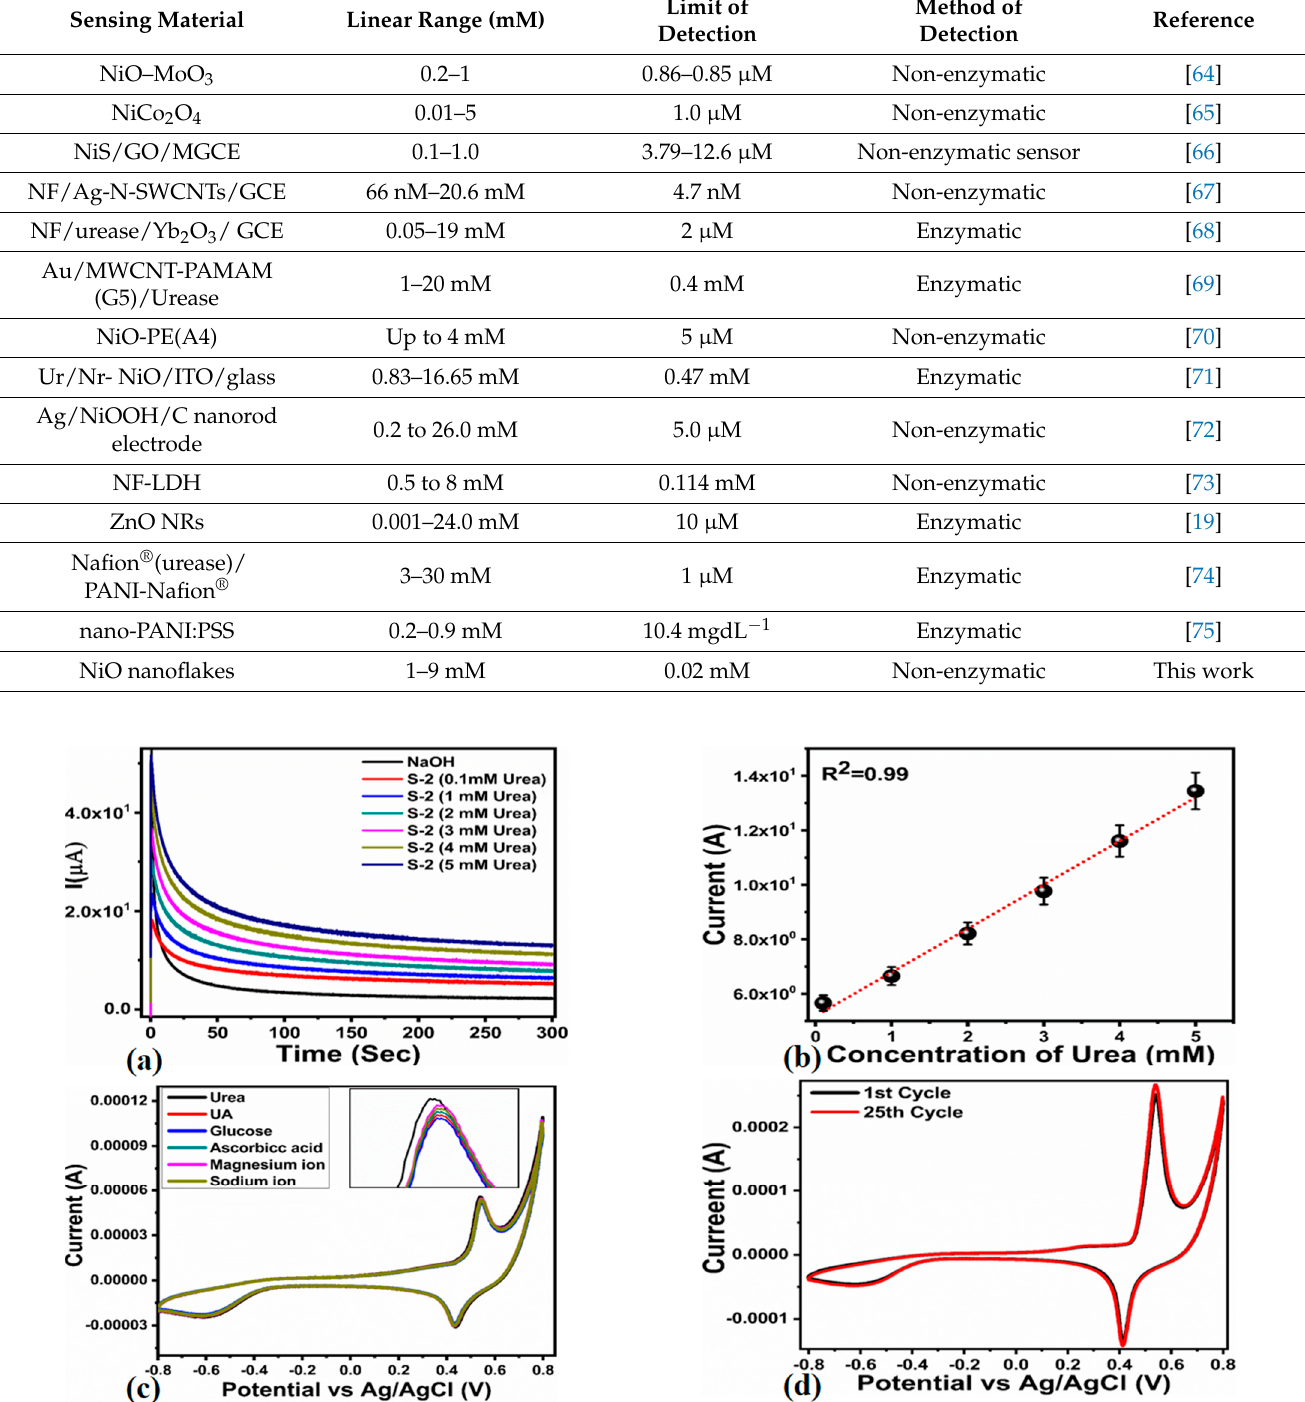
Figure 5. ( a ) Chronoamperometric response of sample 1 against various concentrations of urea, ( b ) linear plot of chronoamperometric current measured at 250 sec for each response time curve against urea concentration ranging from 0.1 mM to 5 mM, ( c ) cyclic voltammogram at 50 mV/s of sample 1 sequencing addition of 0.1 mM of common interfering agents in the presence of 0.1 mM urea, inset shows the drift in the peak current for addition of each interfering agent for better understanding, ( d ) CV curves measured for 25 repeatable cycles of same electrode for measuring the stability in 0.1 mM urea.